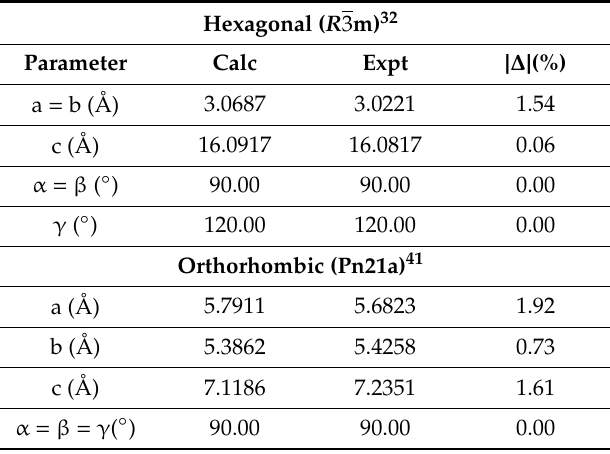
Table 1. Experimental and calculated structural parameters for hexagonal ( α ) and orthorhombic ( β ) NaFeO